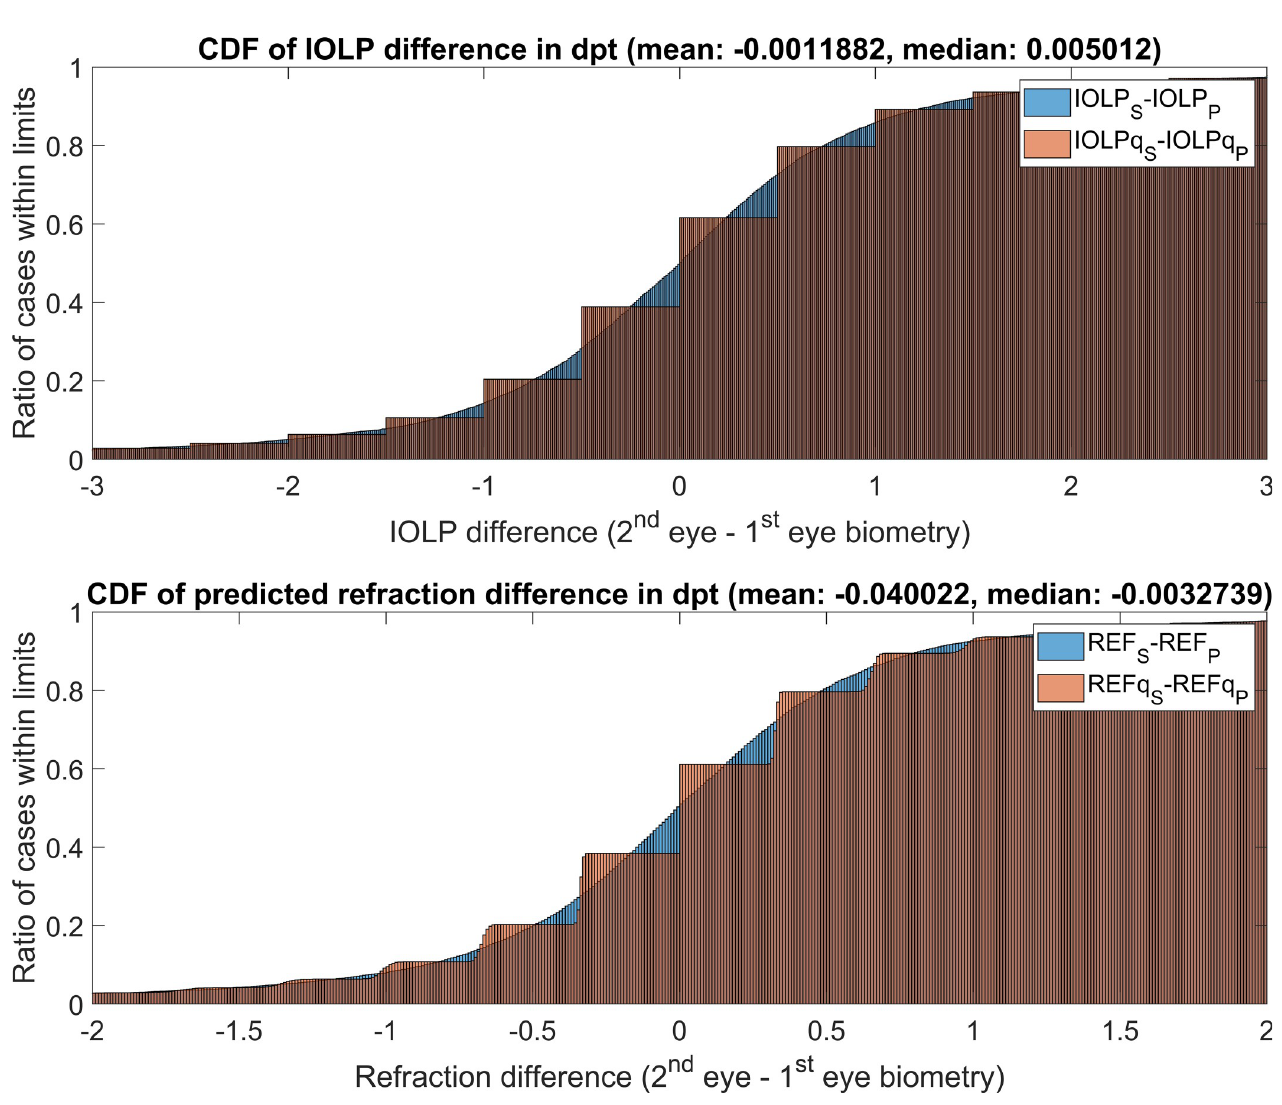
Fig 3. Normalised cumulative density functions (CDF): In the upper graph the difference between the lens power derived with the biometry of the secondary eye and the lens power derived with the biometry of the primary eye is shown (IOLP S-P = IOLP S -IOLP P ), whereas in the lower graph the resulting predicted refraction at the spectacle plane (REF S-P = REF S -REF P ) is displayed where the intraocular lens derived from the secondary eye biometry (IOLP S ) is inserted (instead of IOLP P ) in the primary eye. The overlay (in red) displays the ‘real world’ scenario of lenses available in steps (here: Quantised to half dioptre steps) and the lens power IOLPq S-P = IOLPq S -IOLPq P (upper graph). The respective refractive outcome is provided in the lower graph (REFq S-P = REFq S -REFq P